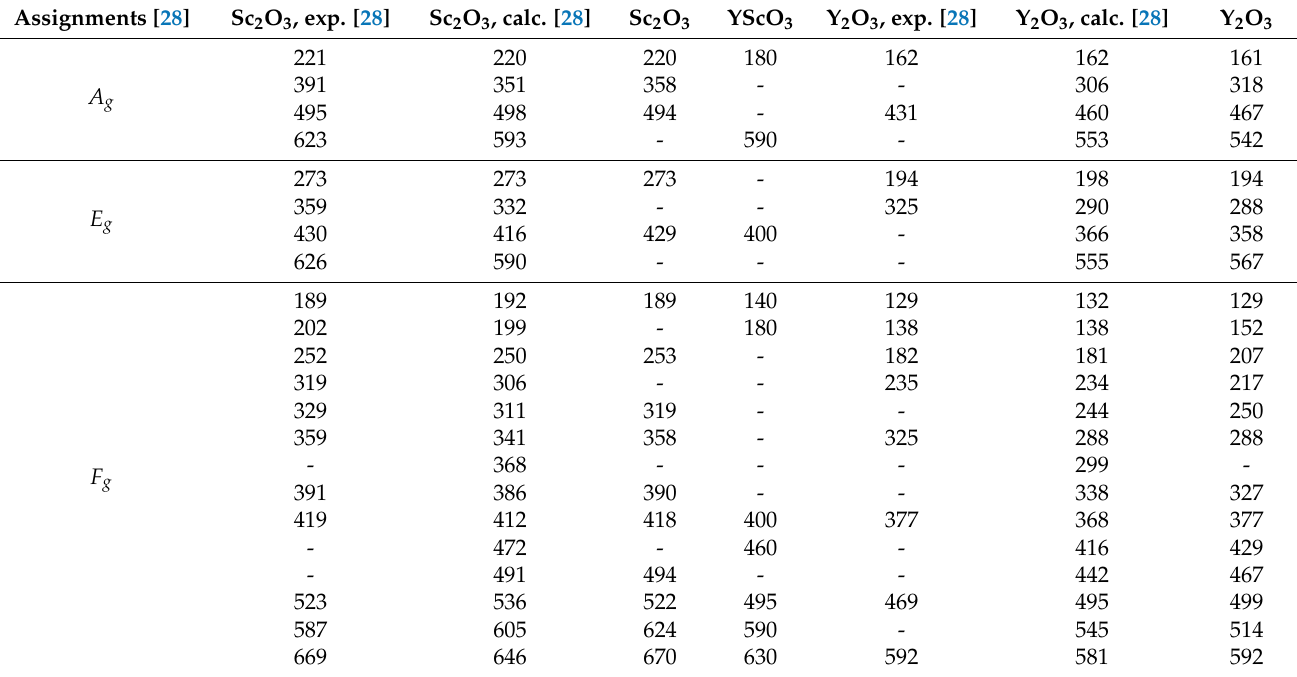
Table 2. Raman-active modes in spectra of Y 2 O 3 , Sc 2 O 3 and YScO 3 ; exp.—experimental, calc.—calculated. Assignments